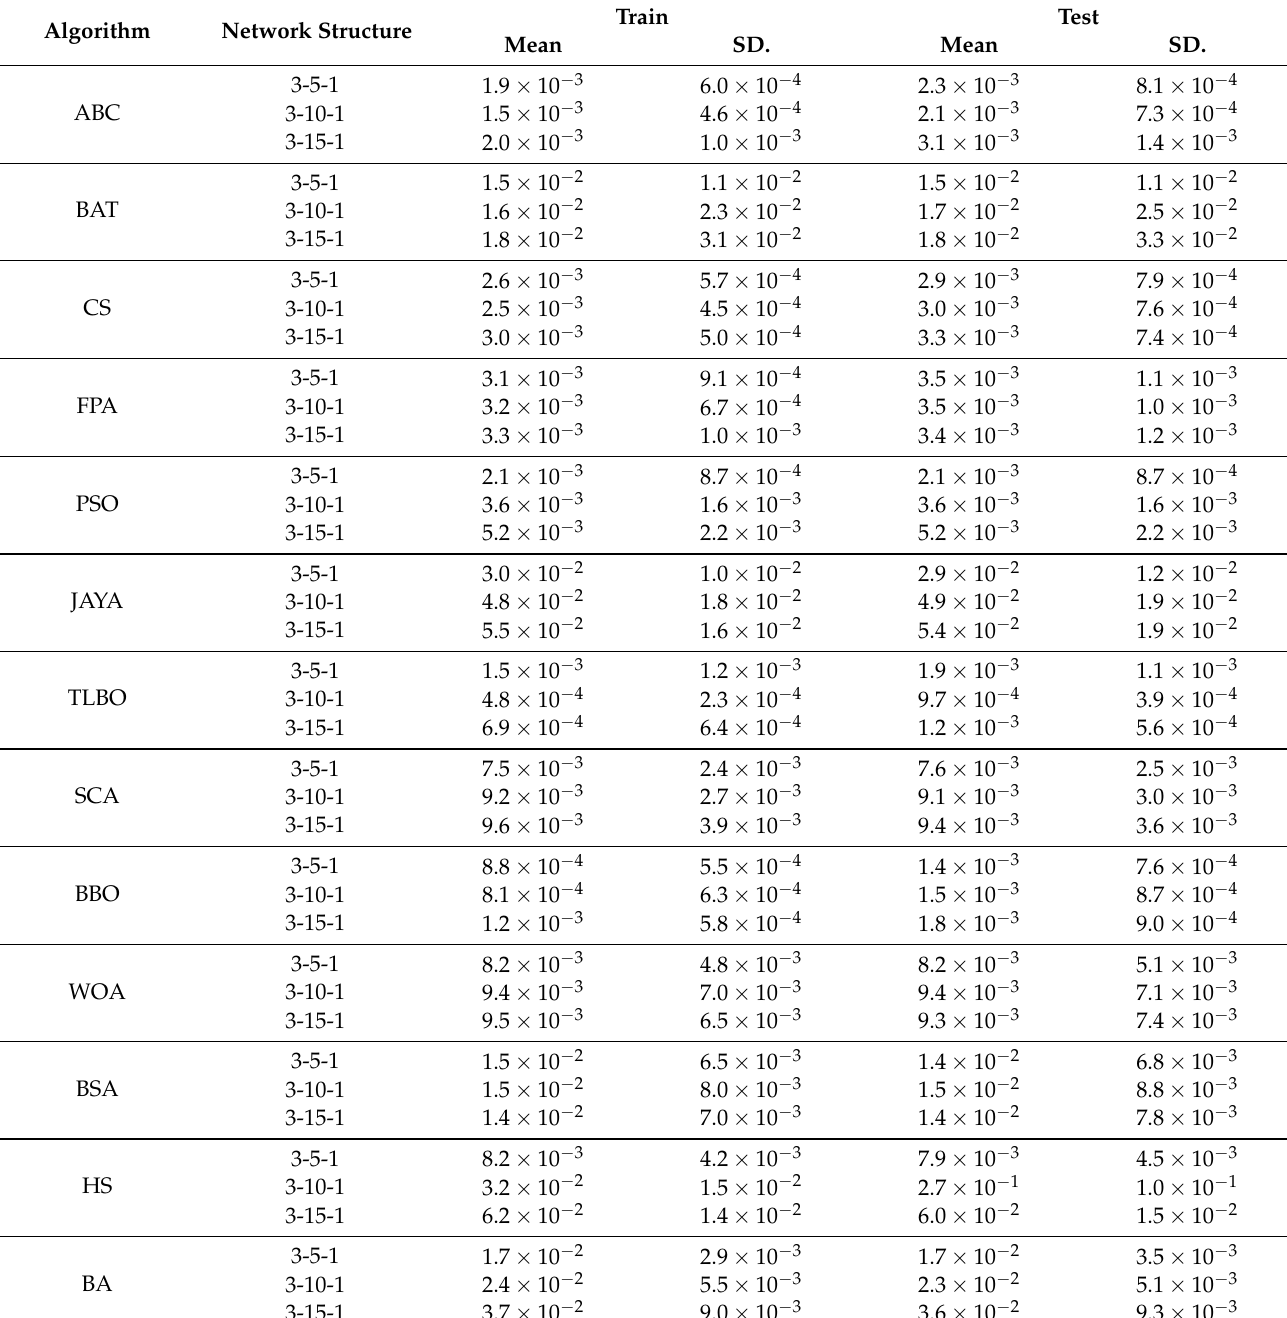
Table 5. The results obtained by using the metaheuristic algorithms for S 4